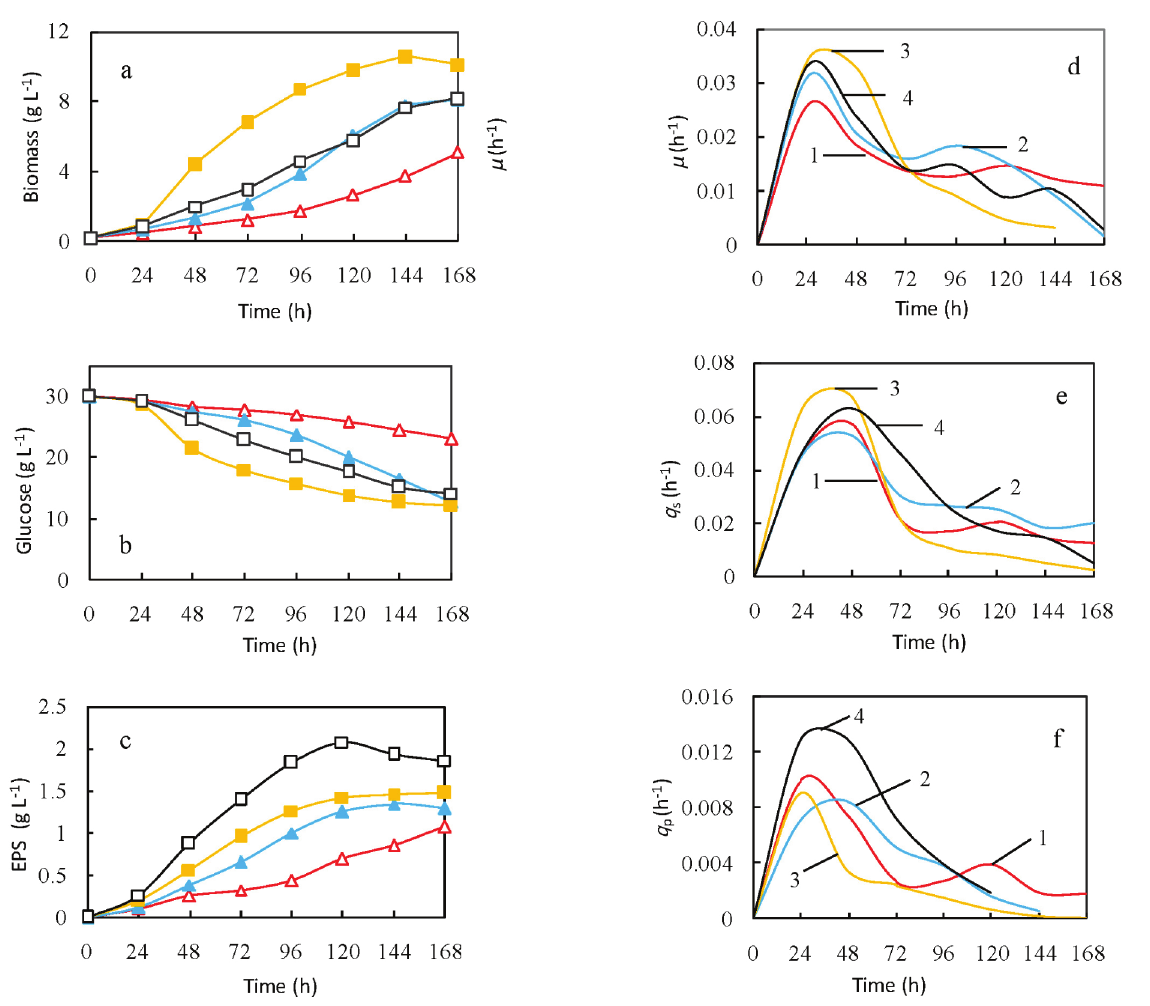
Fig. 3 – Time courses of submerged culture of H. marmoreus in 5-L fermenter under different constant pH. pH 4.5 (  and 1), pH 5.5 (▲ and 2), pH 6.5 (■ and 3) and pH 7.5 (□ and 4).